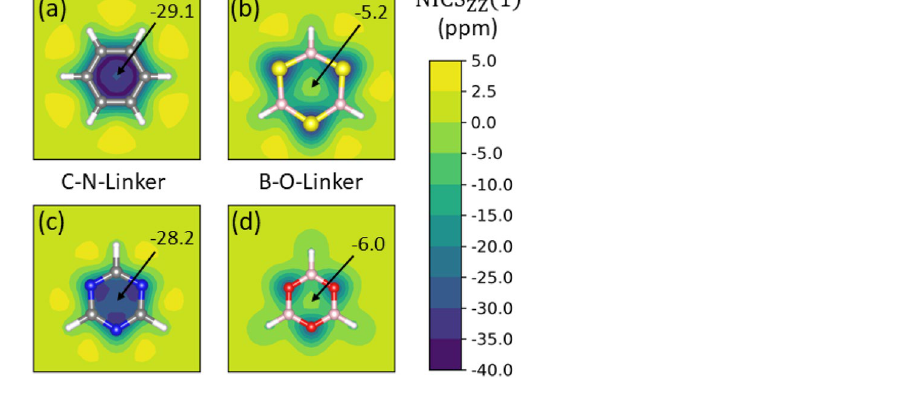
Figure 2. NICS ZZ ( 1 ) -scan for all basic building blocks of the investigated COFs. Linker units are terminated with hydrogen.